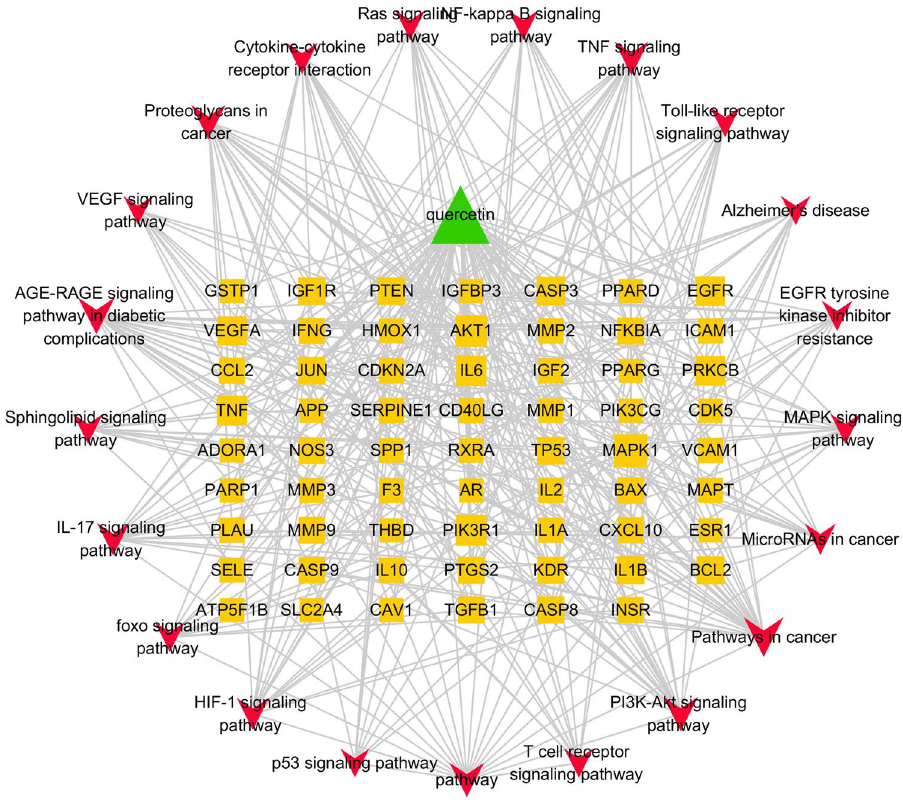
Figure 6. Component–target–pathway network for quercetin targets relevant to T2DM and AD treatment.